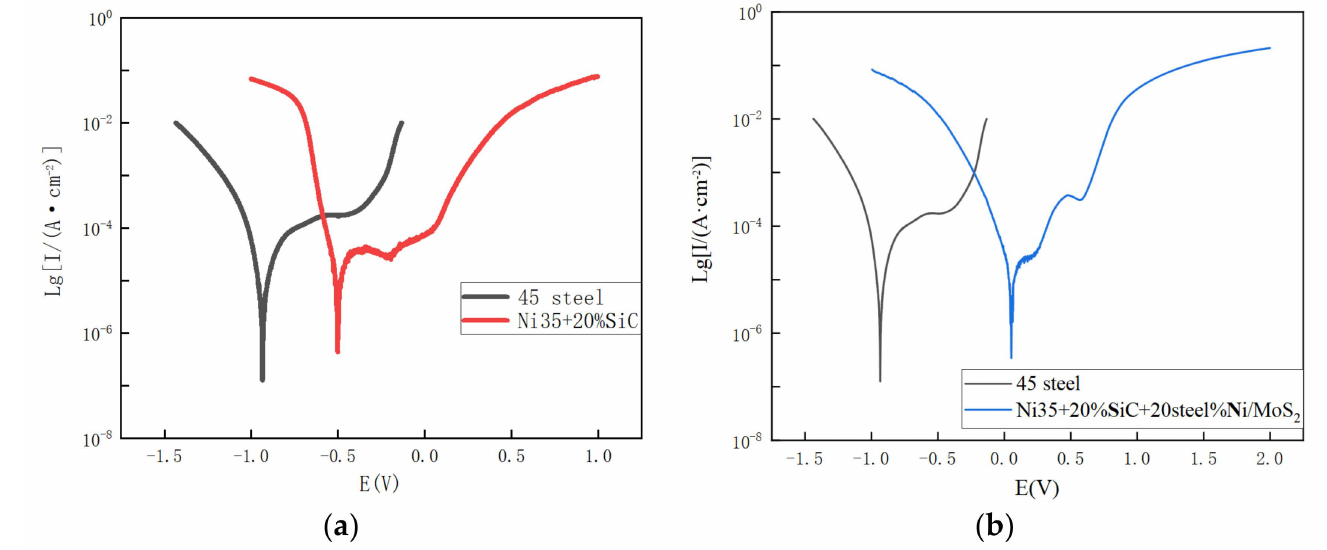
Figure 7. Polarization curve of grade 45 steel and coating in 3.5% NaCl solution. ( a ) Ni35 + 20% SiC, ( b ) Ni35 + 20% SiC + 20% Ni/MoS 2 coating.